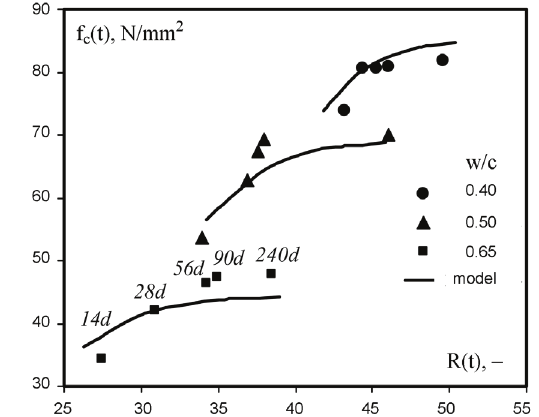
Fig. 5. Parametric simulation to the model Fig. 6. Experimental results together with the parameter fitted